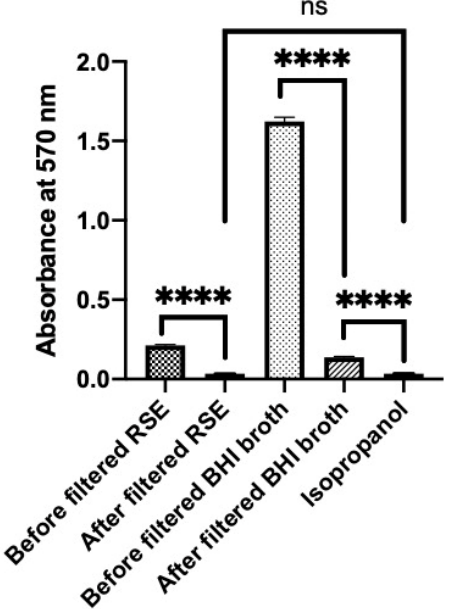
Figure 2. The optical density results of the NZ ‘Hass’ avocado ripe seed extracts (RSE), and the BHI broth before (isopropanol dissolving) and after (column chromatography) fi ltering. RSE before fi ltering: avocado ripe seed extract dissolved in isopropanol; BHI broth before fi ltering: pure BHI broth dissolved in isopropanol; RSE after fi ltering: avocado ripe seed extract solution obtained after column chromatography fi ltration; BHI broth after fi ltering: pure BHI broth obtained after column chromatography fi ltration. Results are expressed as the mean ± SD. Quadruple asterisks (****) indicate p < 0.0001. ns indicates p > 0.05.